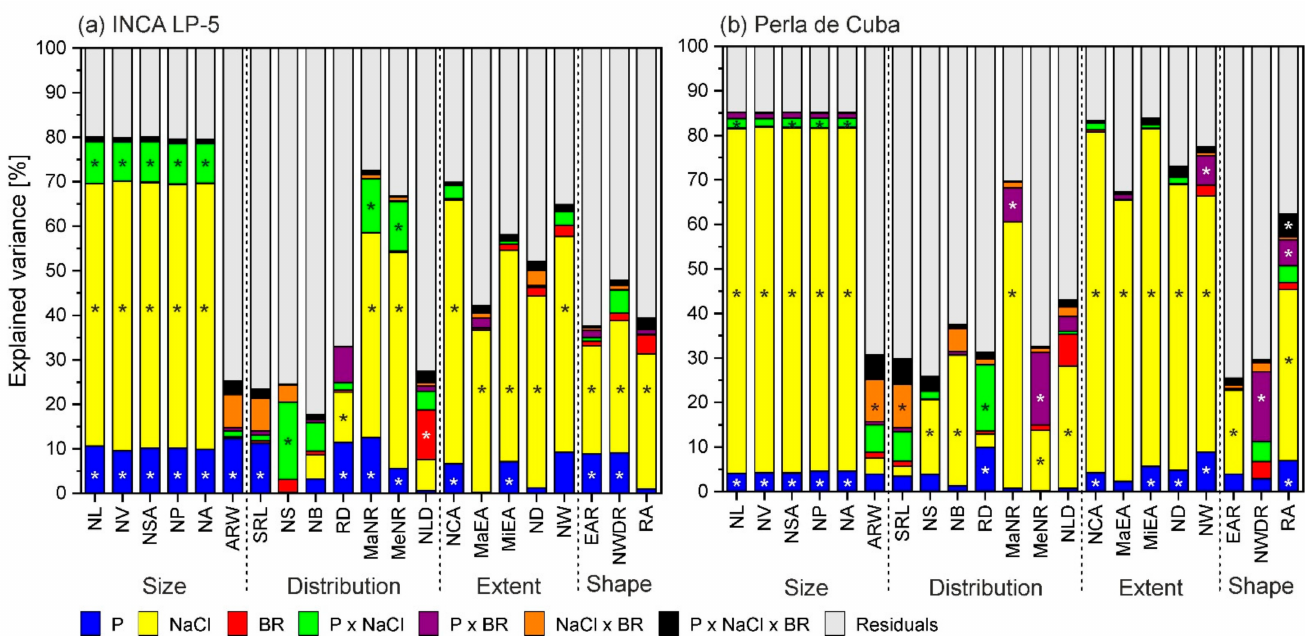
Figure 5. Variance in root-system traits (%) explained by the experimental factors phosphorus (P), salt (NaCl), 24-epibrassinolide (BR) and their interactions in the two rice genotypes INCA LP-5 ( a ) and Perla de Cuba ( b ). Signif- icant factors are marked with an asterisk. NL: network length; NV: network volume; NSA: network surface area; NP: network perimeter; NA: network area; ARW: average root width; SRL: specific root length; NS: network solidity; NB: network bushiness; RD: lateral root density; MaNR: maximum number of roots; MeNR: median number of roots; NLD: network length distribution; NCA: network convex area; MaEA: major ellipse axis; MiEA: minor ellipse axis; ND: network depth; NW: network width; EAR: ellipse axis ratio; NWDR: network width-to-depth ratio; RA: root